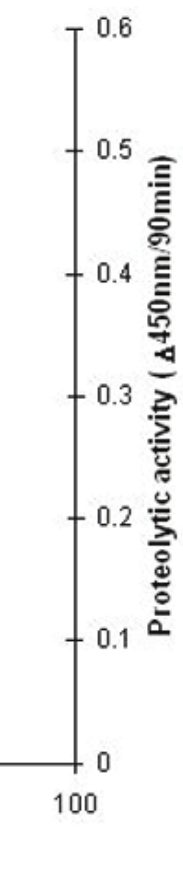
Figure 4. Gel filtration chromatography of the ATPS bottom phase on Sephadex G-75. Absorbance at 280nm ( ● ). Proteolytic activity (---) according to the method of Wang and Huang (26). Fractions that exhibited Phospholipase A2 activity ( ↔ ).